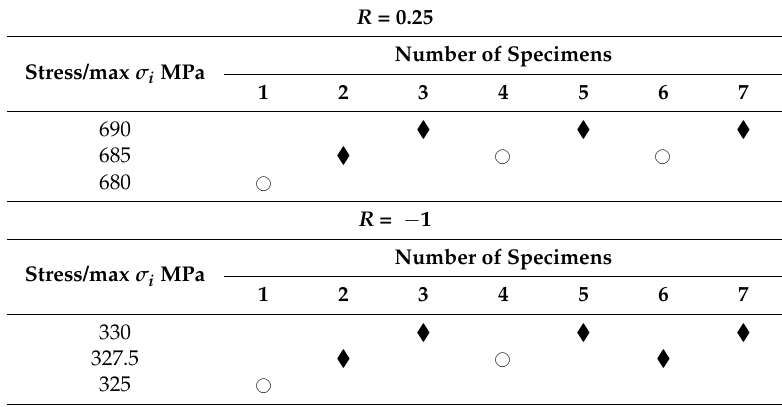
) specimens (cid:35)